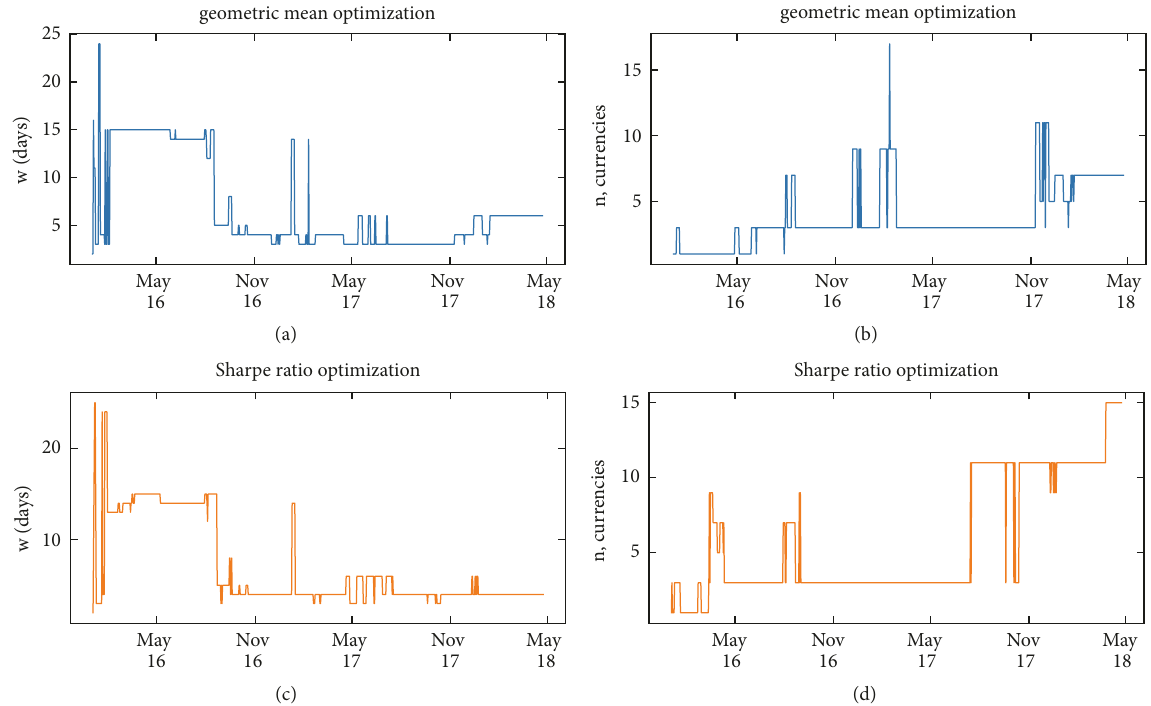
Figure 8: Baseline strategy: parameters optimisation. The sliding window 𝑤 (a, c) and the number of currencies 𝑛 (b, d) chosen over time under the geometric mean (a, b) and the Sharpe ratio optimisation (c, d). Analyses are performed considering prices in BTC.